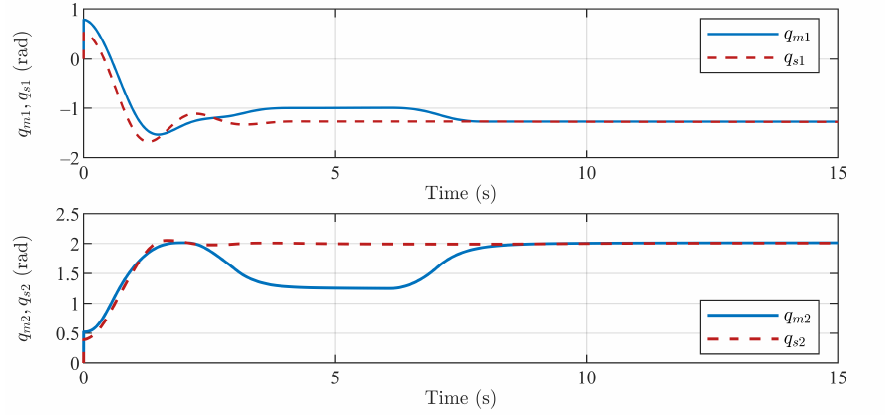
Figure 4. Joint positions of the master and slave robots.